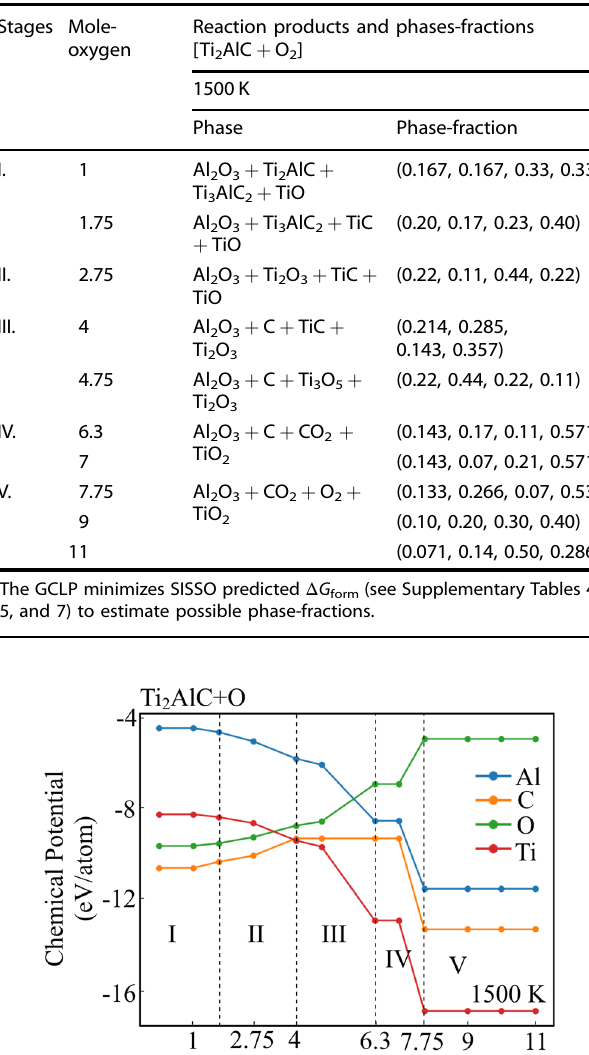
Table 2. Predicted set of thermodynamically favored reaction products in Ti 2 AlC + O 2 at reaction temperature of 1500 K.